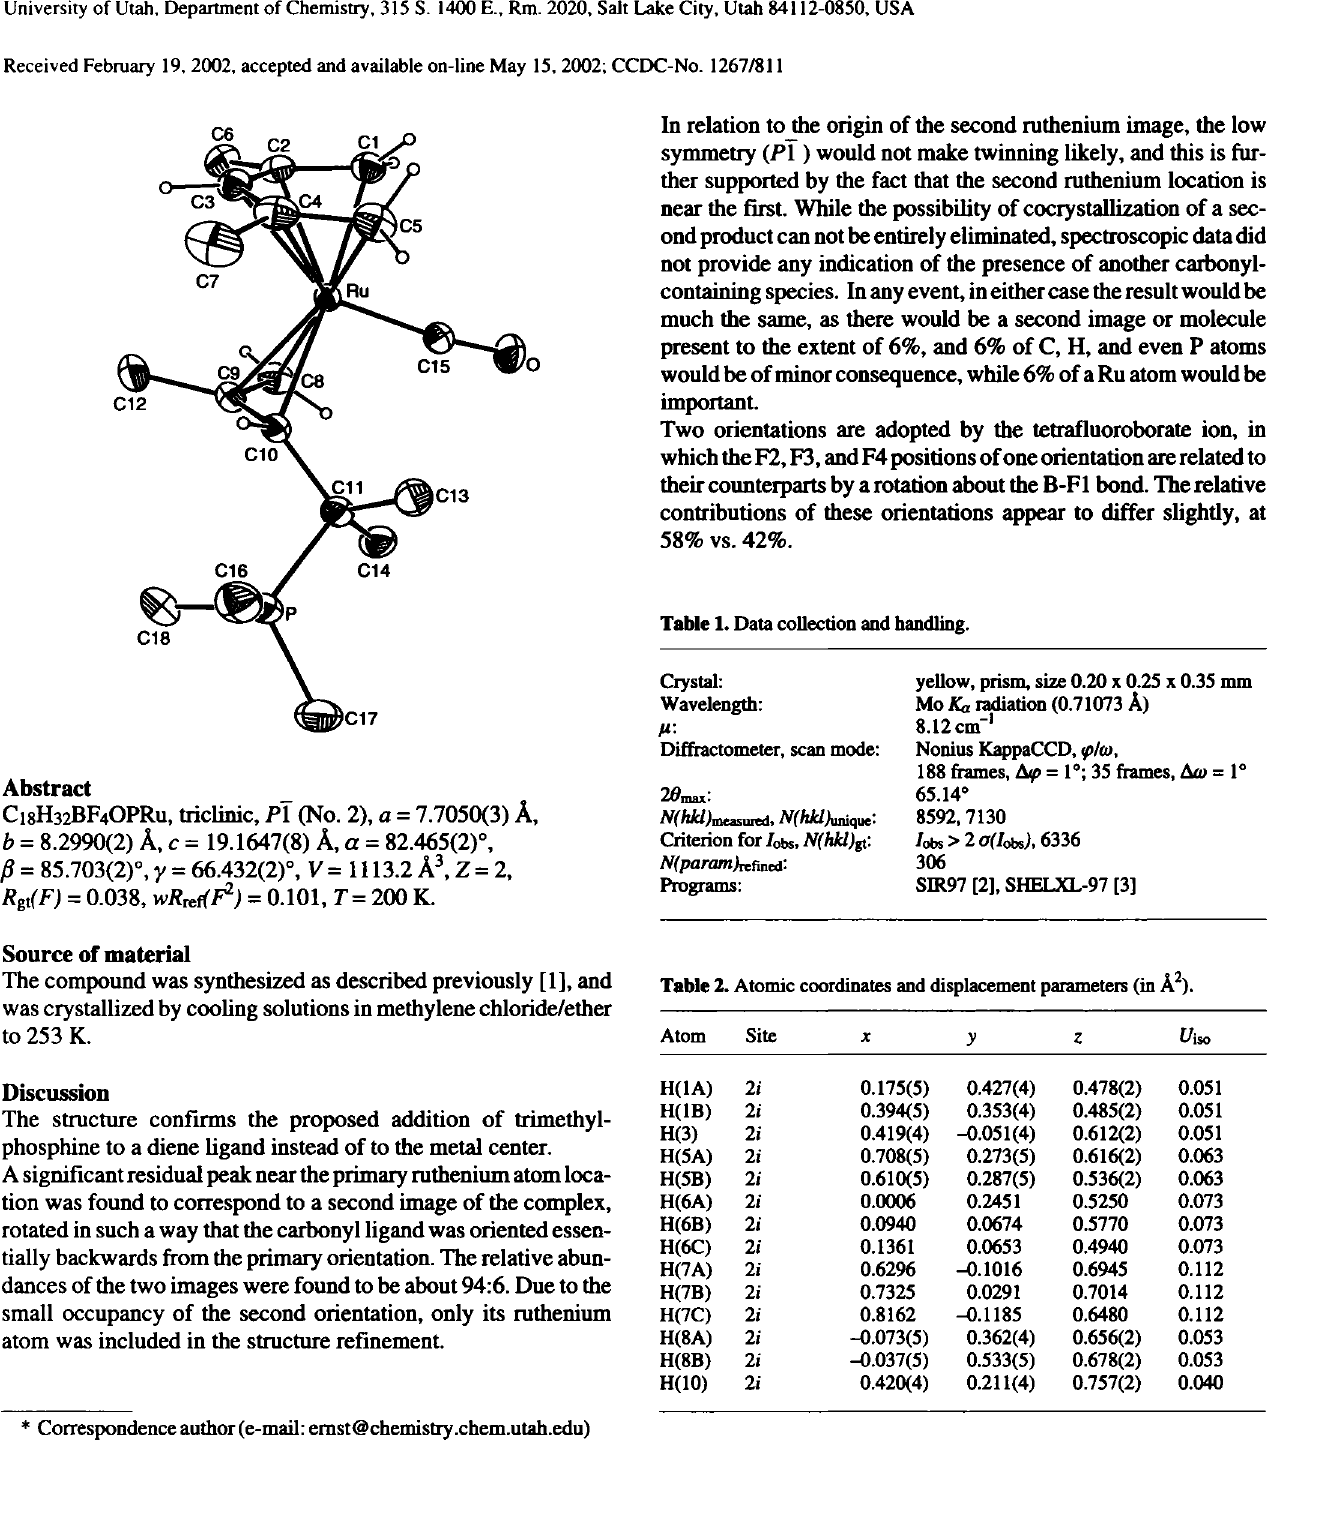
Table 2. Atomic coordinates and displacement parameters (in Â 2